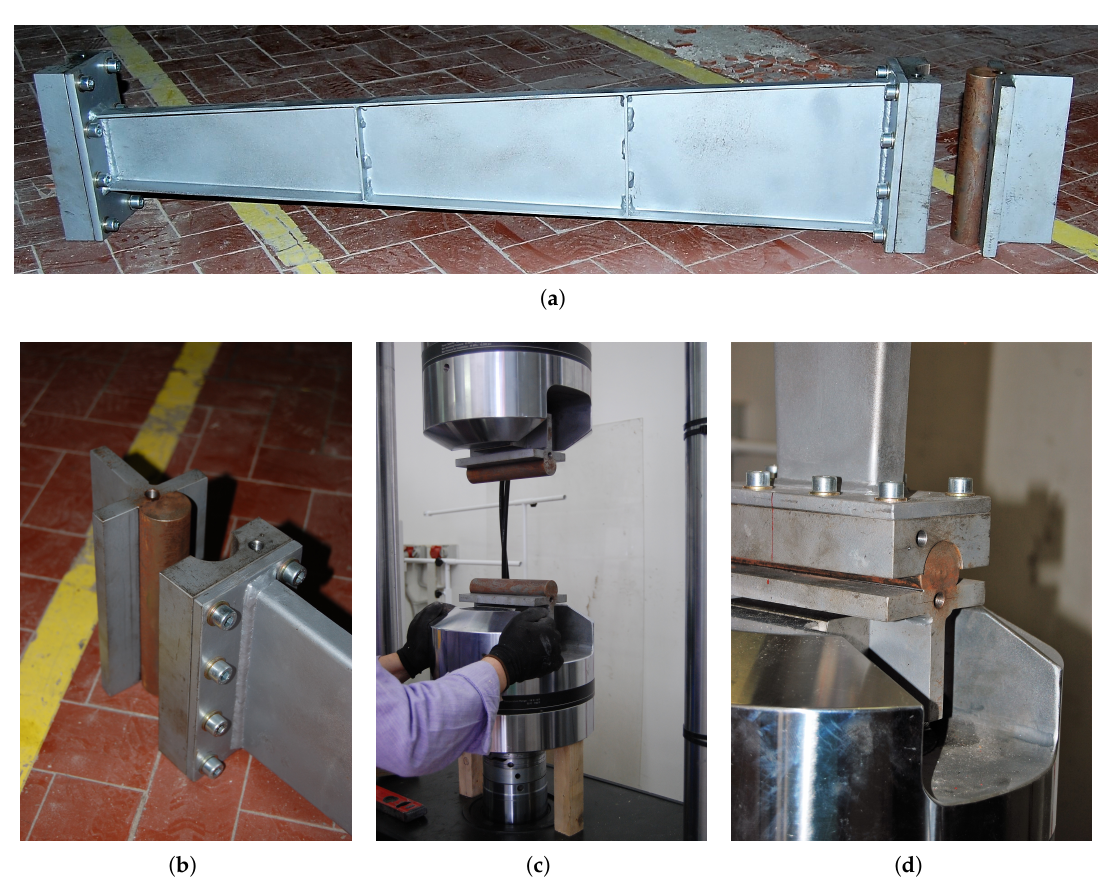
Figure 4. Physical model of the analyzed beam ( a ); cylindrical hinge at the basis of the beam ( b ); connection of the beam supports to the grips of the testing machine ( c ); base of the physical model mounted on the testing machine ( d